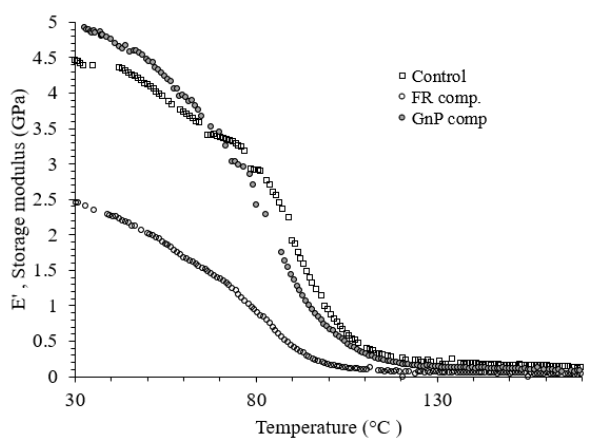
Figure 8. Dynamic mechanical analysis (storage modulus vs. temperature) of the composites.